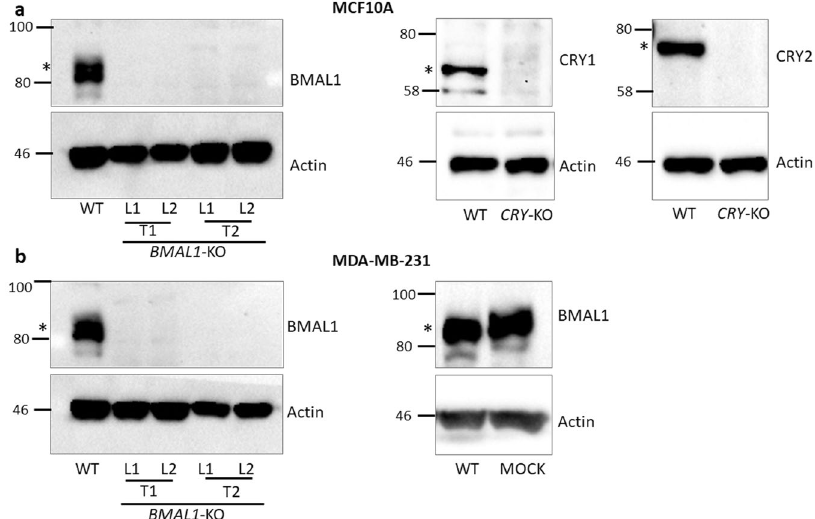
Figure 1. Confirmation of BMAL1 knockouts. The BMAL1 gene was knocked out using the LentiCRISPRv2 system by targeting the gene separately at two different locations using T1 and T2 sgRNAs to eliminate non- specific off-target effects. CRY1 and CRY2 ( CRY -DKO) were also knocked out in both cell lines as a control (MDA-MB-231 CRY -DKO data are presented in Supplementary Fig. S4). ( a ) Immunoblot of BMAL1, CRY1, and CRY2 proteins in the MCF10A clones confirmed that the knockouts were successful. CRY -DKO was used a control for the apoptosis experiments because CRY did not affect apoptosis in the presence of wild-type p53. ( b ) MDA-MB-231 BMAL1 knockouts were obtained using the same protocol as for MCF10A, and the knockouts were confirmed with BMAL1 immunoblotting. Because MDA-MB-231 cells have mutant p53 , CRY mutation amplified apoptosis in response to cisplatin treatment, as expected, which is in agreement with our previous publication (see Supplementary Fig. S4). We obtained a mock cell line of MDA-MB-231, which was infected with BMAL1- targeting lentivirus, but escaped the knockout process as confirmed by the presence of the BMAL1 protein. Actin was blotted as a loading control. T1 and T2 represent two separate sgRNAs for BMAL1 gene. L1 and L2 are subclone lines originating from T1 or T2 targeting. WT represents parental cell lines, and * indicates the specific signal for circadian clock proteins, which were blotted. Numbers and marks on the left of each figure indicate the positions of the corresponding molecular size markers in kDa. Full-length blots are presented in Supplementary Fig.